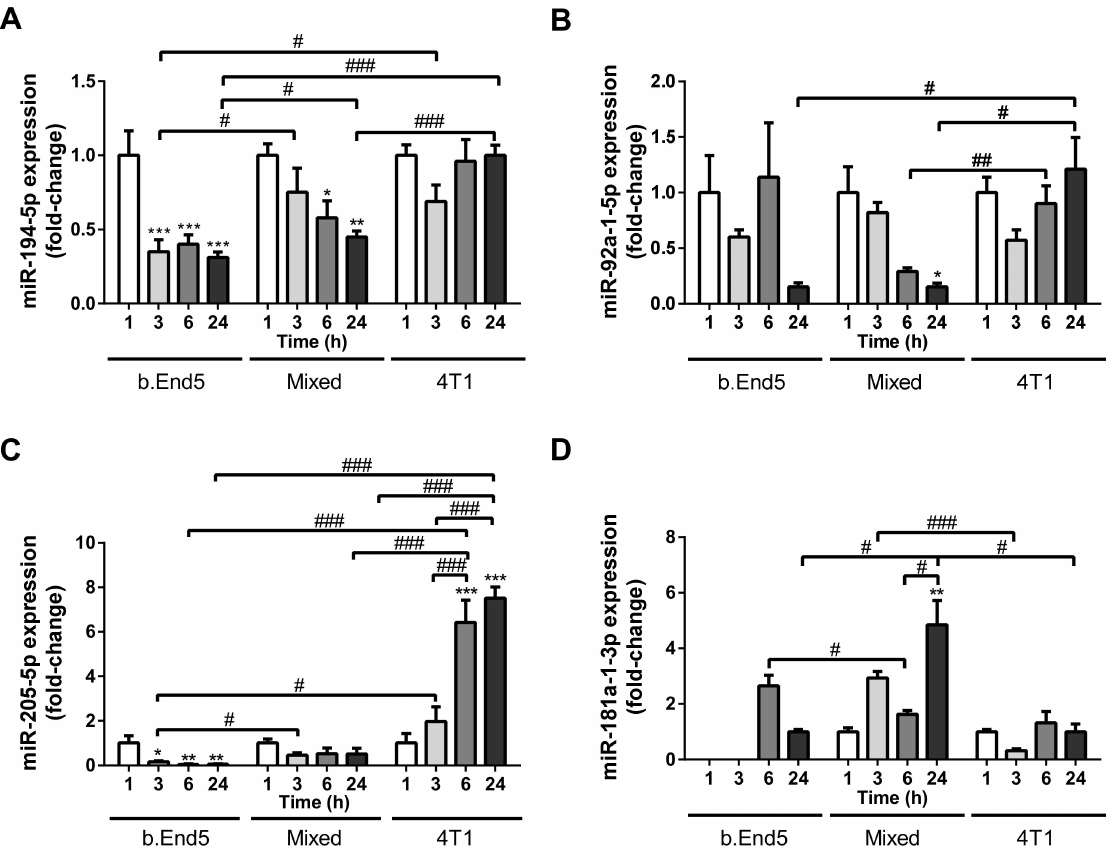
Figure 3. Differential release of miRNAs by single cultures of brain microvascular endothelial cells (BMECs) or breast cancer cells (BCCs), and mixed BMEC–BCC cultures. Single cultures of 4T1 cells (BCCs), b.End5 cells (BMECs) and mixed cultures of b.End5 and 4T1 (previously labelled with CellTracker™ Green) cells, were performed under physiological shear stress for 1, 3, 6 and 24 h, after which the media were collected and processed for real time quantitative PCR of the indicated miRNAs. The results are presented as fold-change vs. 1 h of each culture system (with the exception of miR-181a-1-3p in b.End5 single cultures, which were normalized for 24 h), and highlight significant alterations with time and between cultures for miR-194-5p ( A ), miR-92a-1-5p ( B ), miR-205-5p ( C ) and miR-181a-1-3p ( D ). Statistical differences are denoted as * p < 0.05, ** p < 0.01, *** p < 0.001 vs. 1 h of each culture, and by # p < 0.05, ## p < 0.01, ### p < 0.001 between indicated conditions, determined by one-way ANOVA within each culture against time, and by two-tailed unpaired Student’s t -test for each time point between cultures. Data represented are means ± SEM, n =